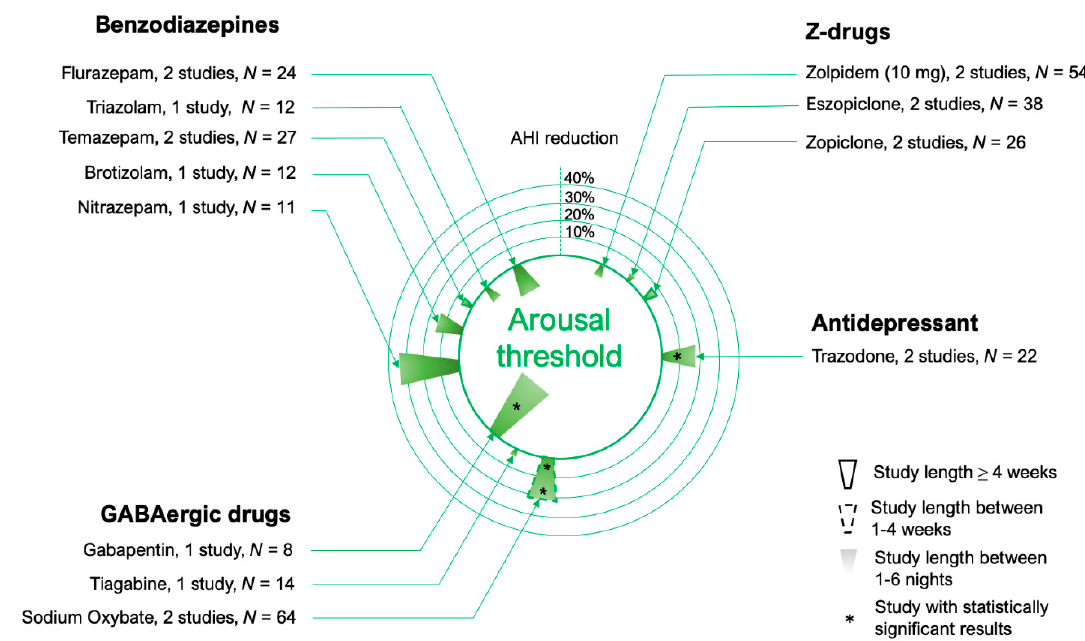
Figure 4. Circular bar plot describing the studies performed using medications that modify the arousal threshold. When multiple doses of a medication were used in different studies, the dose considered is specified in the